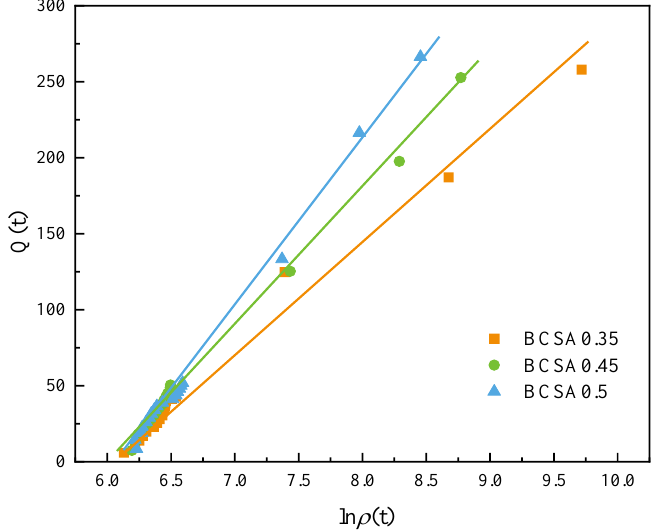
Figure 9. Correlation between cumulative hydration heat and electrical resistivity of BCSA pastes with various w / c ratios.